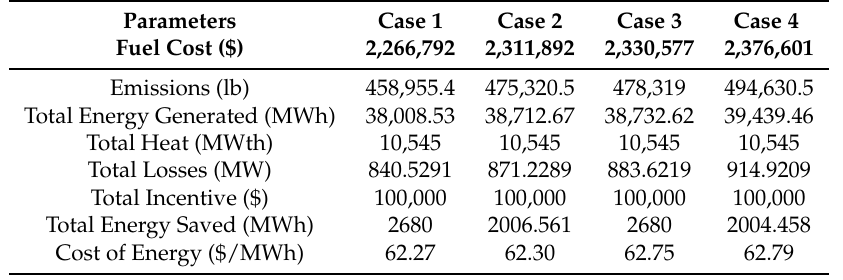
Table 6. Results for the case studies.